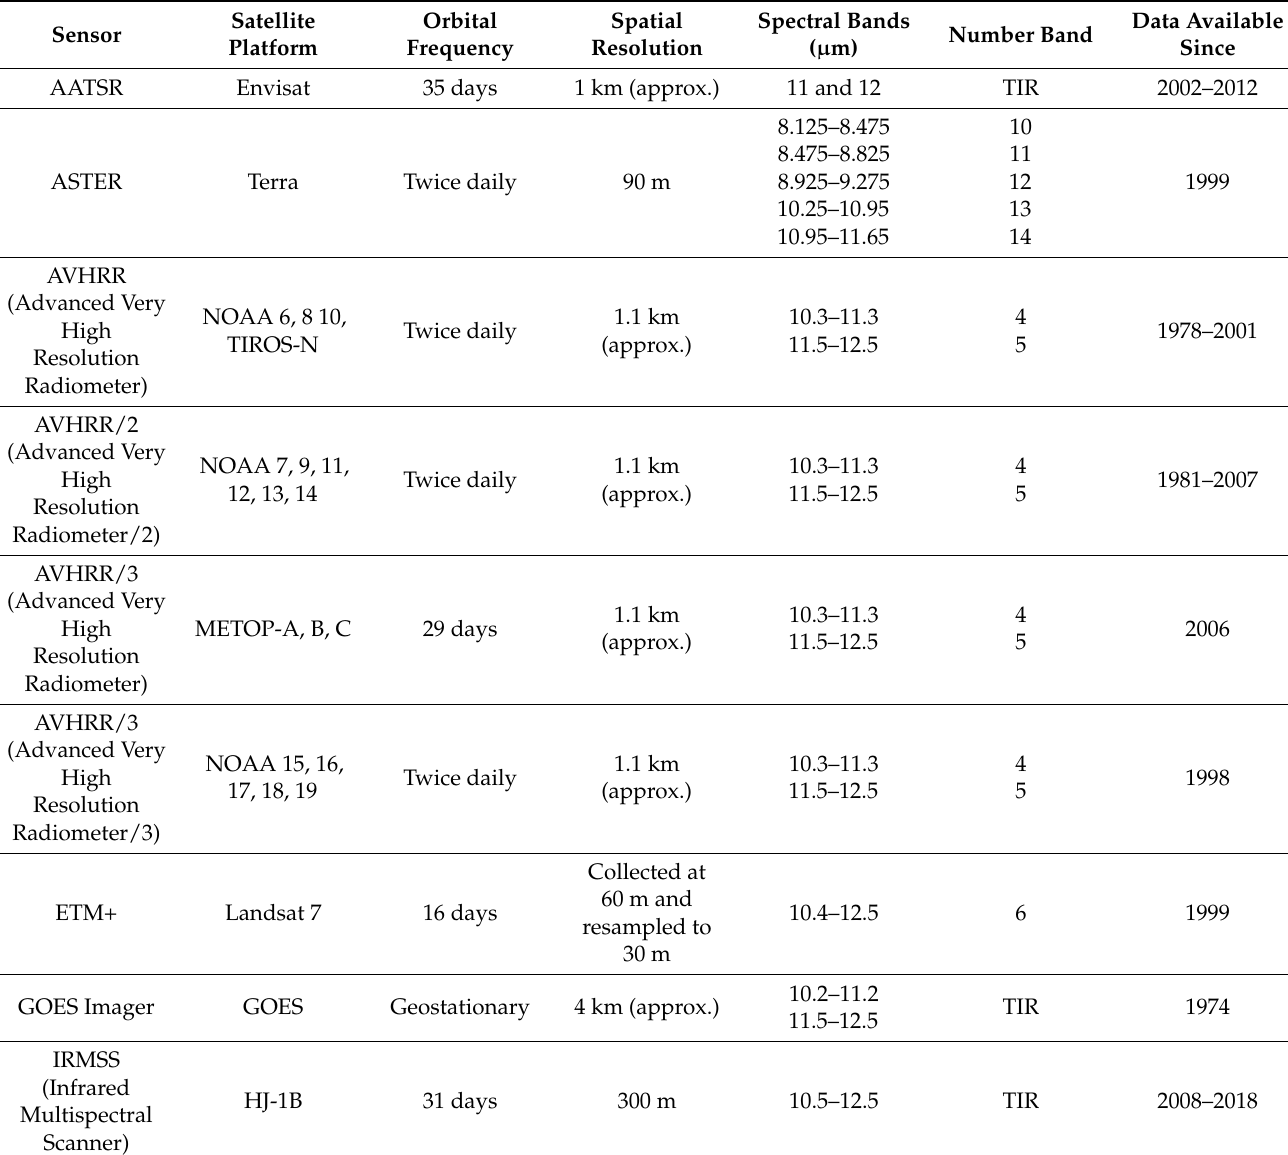
Table 1. Summary of the thermal sensors most commonly applied in UHI studies (adapted from [37,41]).